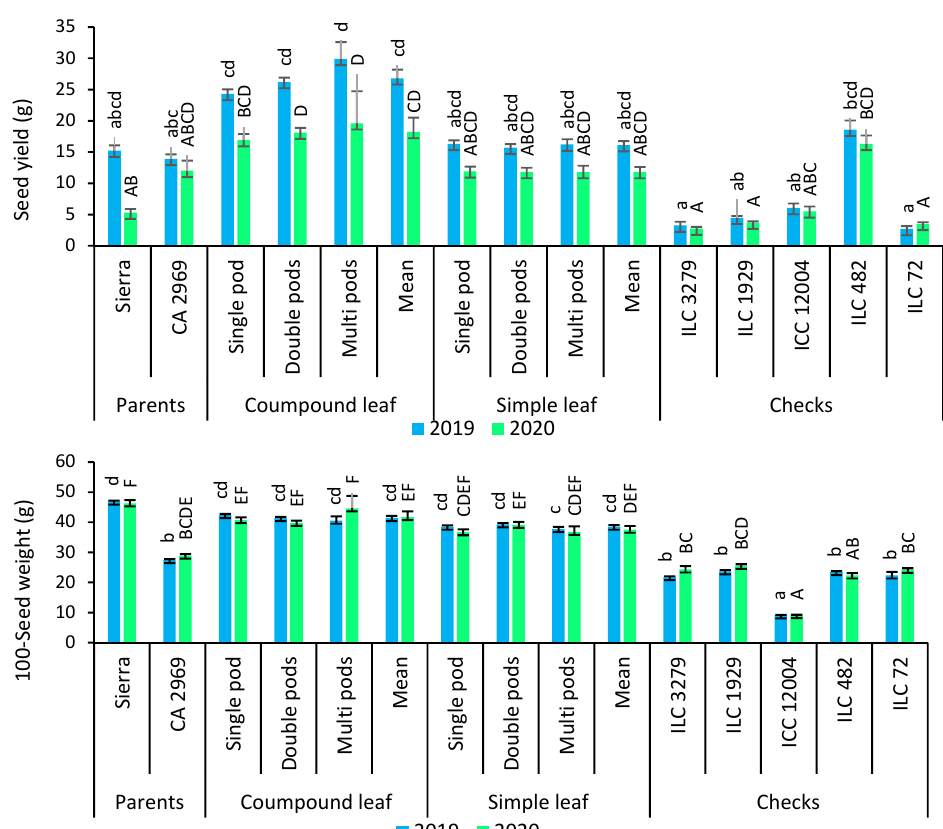
Figure 5. Comparison of compound-leafed versus simple-leafed and multi-podded versus double- podded and single-podded chickpeas with parents and checks for seed yield and 100-seed weight. Different lowercase letters and uppercase letters represent the significant difference ( p ≤ 0.05) between the means for 2019 and 2020, respectively.